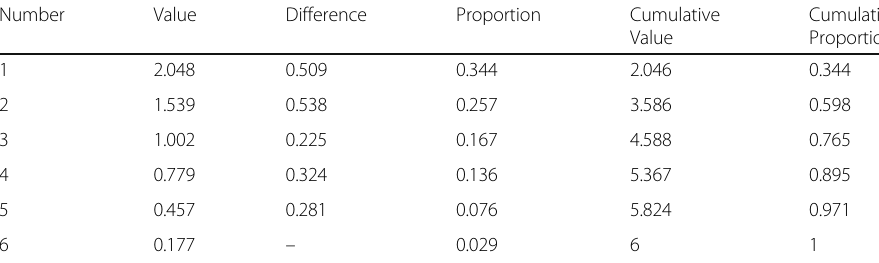
Table 2 Cumulative proportion of sentiment proxies Number Value Difference Proportion Cumulative